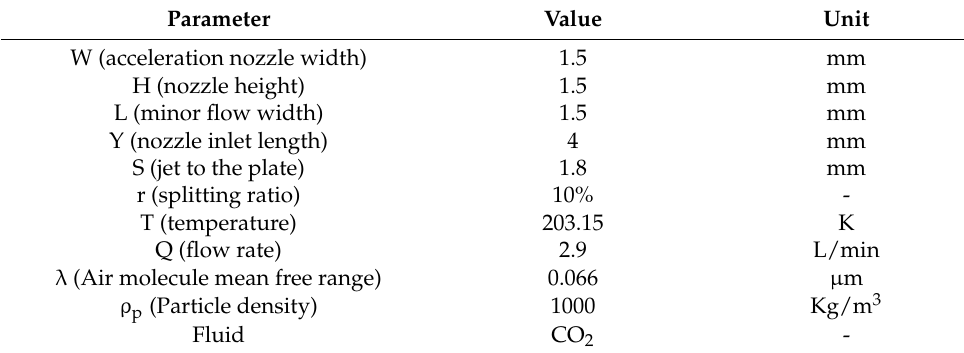
Table 1. Parameter design of new virtual impactor.